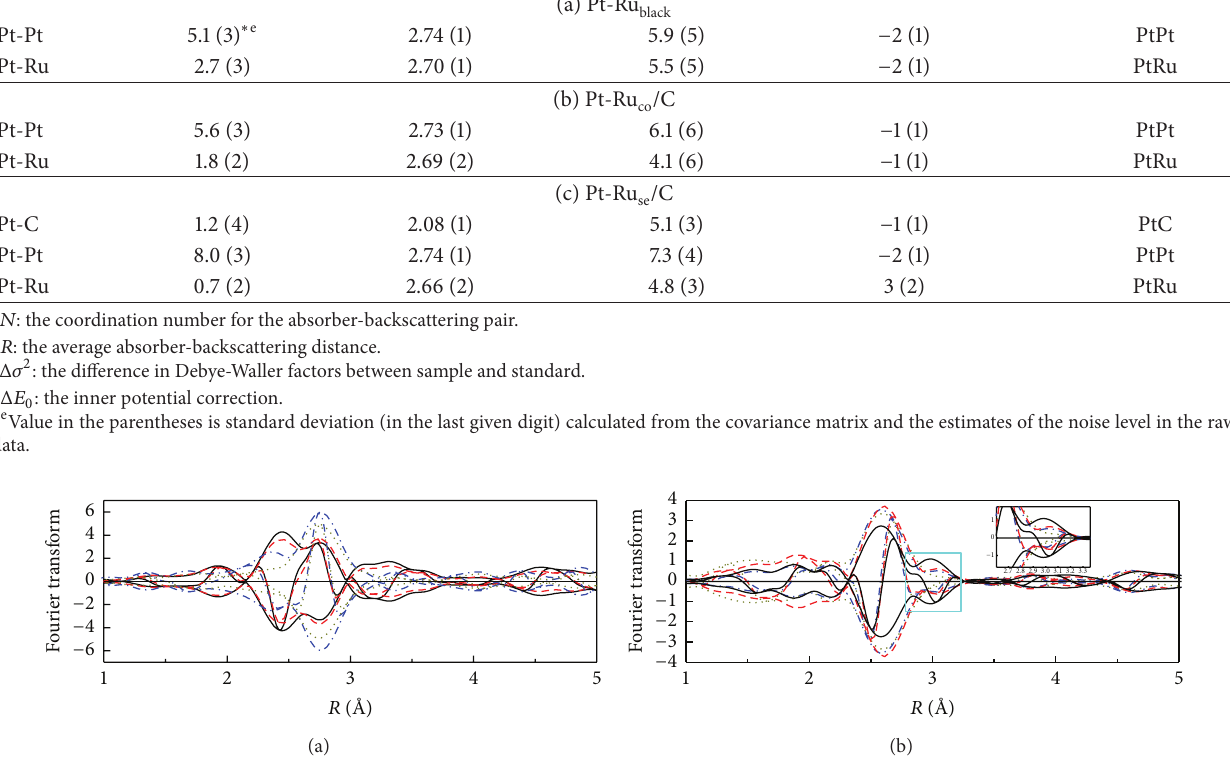
Table 1: Summary of EXAFS analysis results for Pt-Ru catalysts at Pt